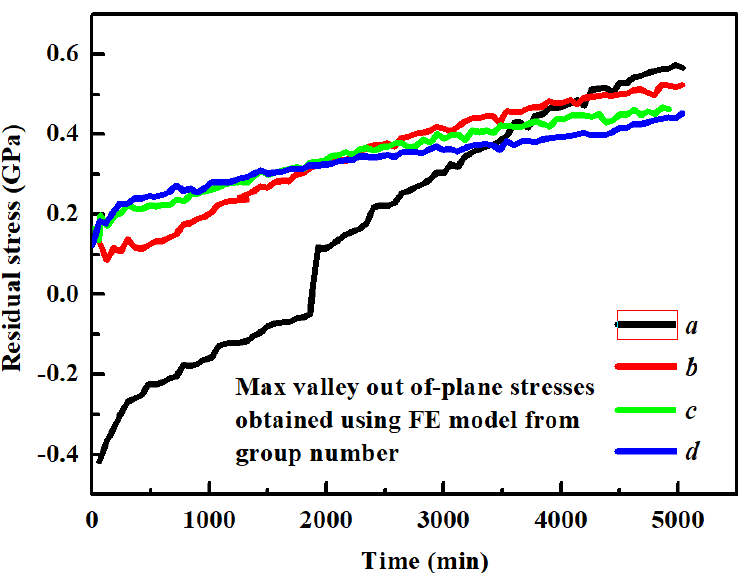
Figure 34. Results of the calculated out-of-plane thermal stresses within the TC with respect to spacing between imperfections.